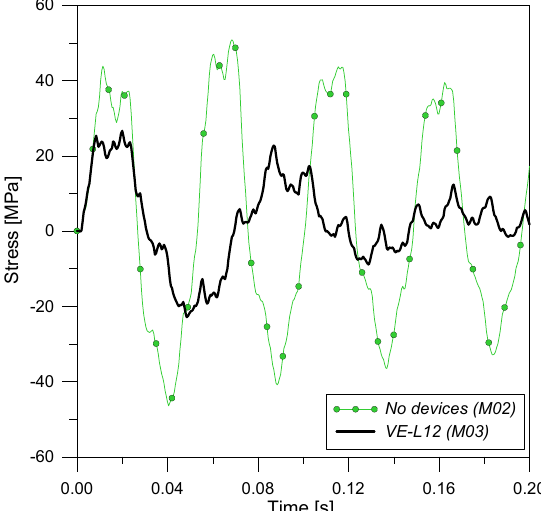
Figure 20. Comparison of maximum tensile stress at the center of panel.